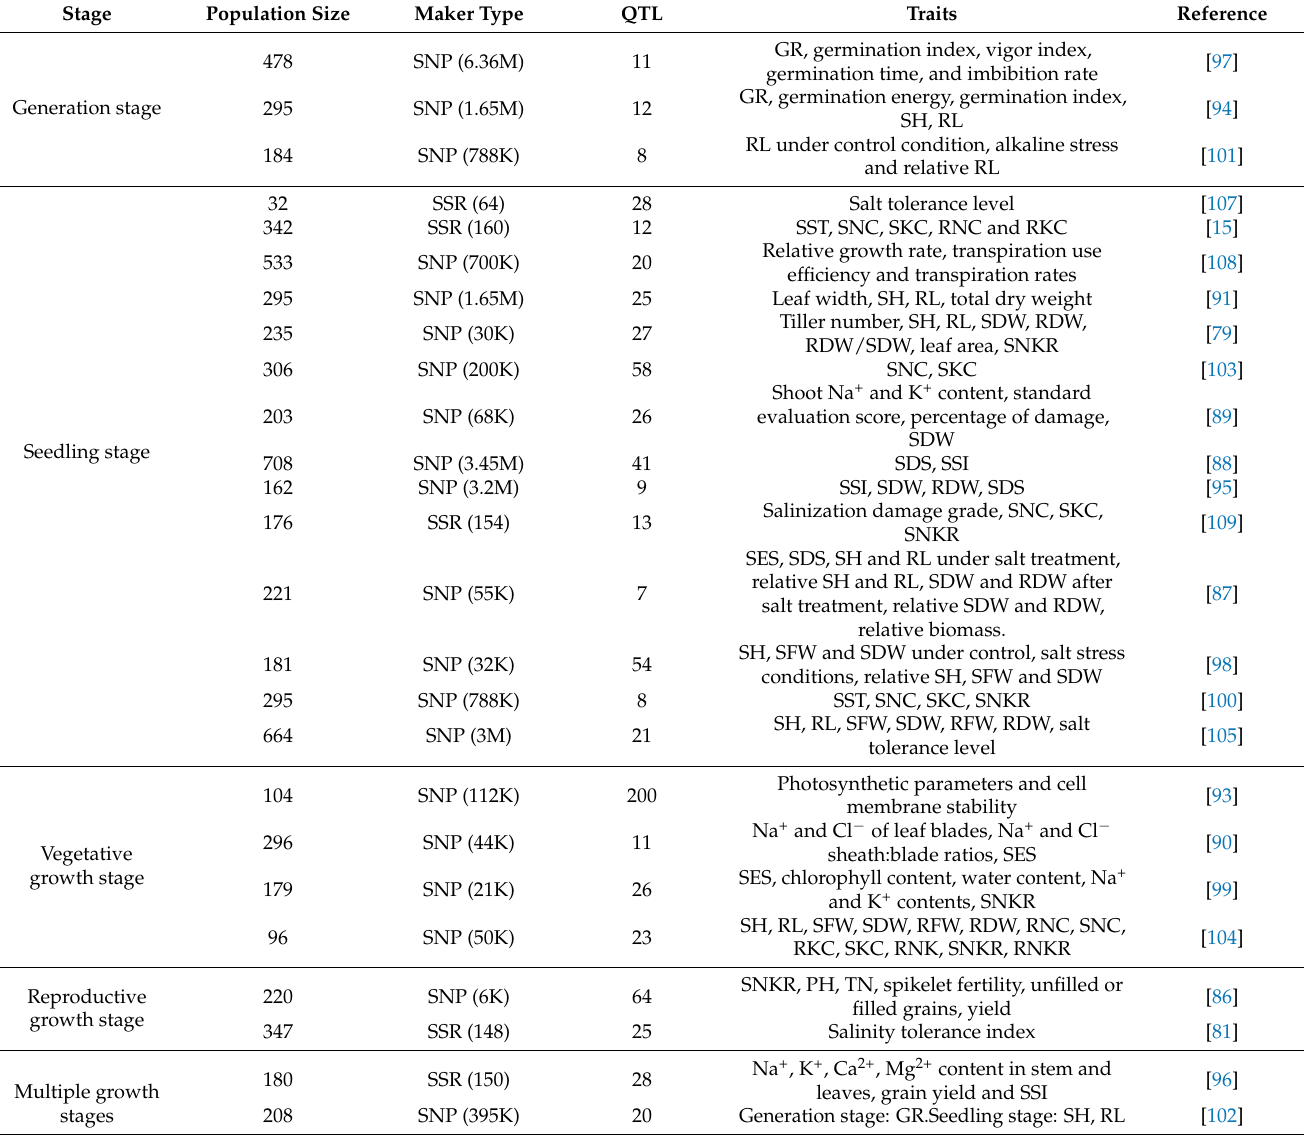
Table 2. Association analysis of salt tolerance in